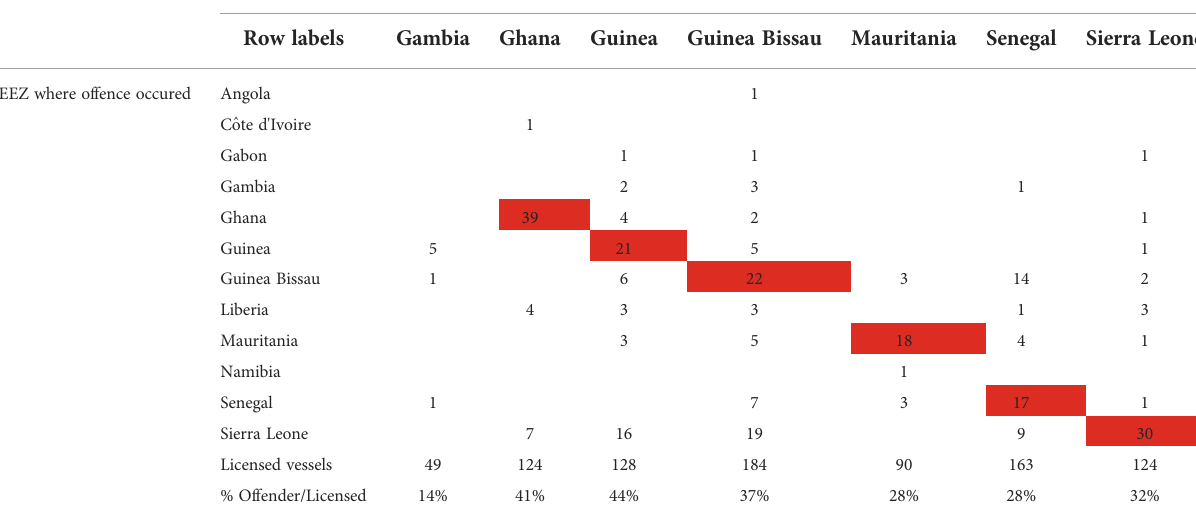
TABLE 5 Number of vessels licensed to fi sh in a coastal state of West Africa, appearing on the criminal record in the neighboring country. EEZ of license Row labels Gambia Ghana Guinea Guinea Bissau Mauritania Senegal Sierra Leone